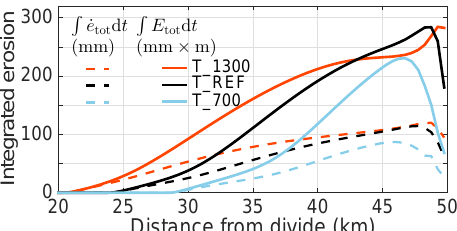
Figure 7. Comparison of time-integrated erosion per unit width ( R ˙ e tot d t ) and total erosion ( R E tot d t ) for different water inputs. The first 20km of the profile are not shown because the bed is alluviated and erosion rates are negligible.